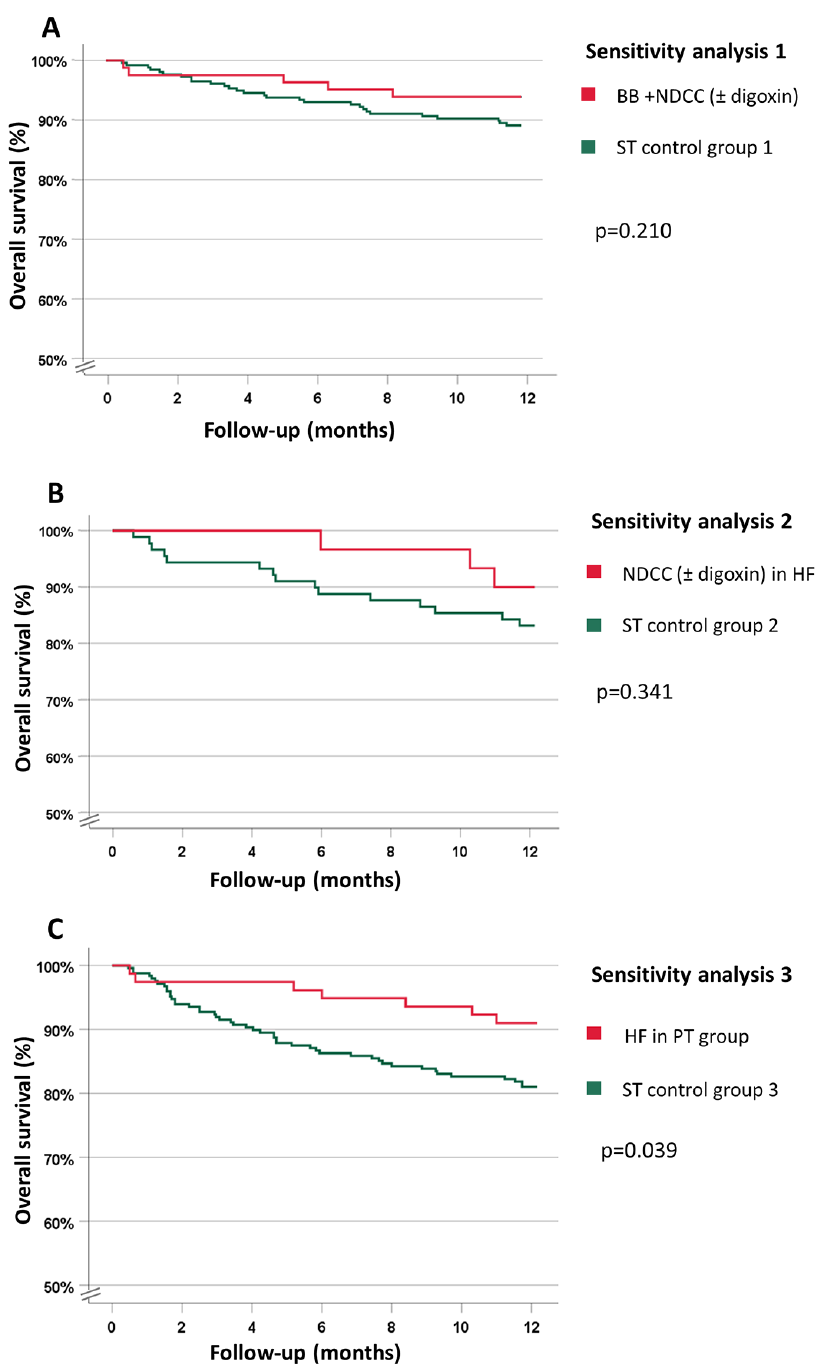
Figure 2. Kaplan–Meier curves. ( A ) Overall survival in patients prescribed BB + NDCC (digoxin) vs. ST Control group 1 (Sensitivity analysis 1); ( B ) Overall survival in patients with HF prescribed NDCC ( ± digoxin) vs. ST Control group 2 (Sensitivity analysis 2); ( C ) Overall survival in patients with HF in PT vs. ST Control group 3 (Sensitivity analysis 3). BB (beta-blockers), NDCC (non-dihydropyridine calcium channel blockers), PT (patient-specific therapy), ST (standard